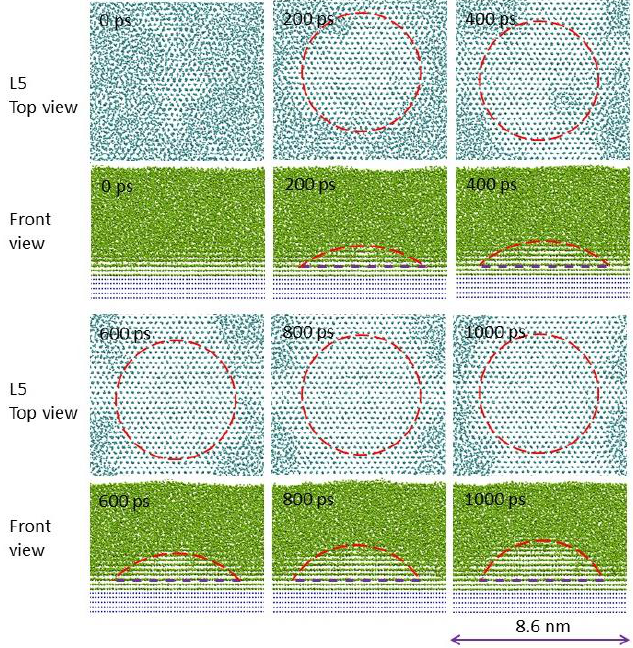
Figure 12. Time-averaged atomic positions of a simulation system with 2% lattice misfit demonstrating the unconstrained cap formation process after nucleation at a higher temperature. Nucleation occurred at Δ T n = 40 K on a substrate of 2r N = 8.6 nm to provide the 2D nucleus that covers the entire substrate surface (see Figure 5). The system was then allowed to solidify at Δ T = 90 K (corresponding to 2r n = 6.3 nm, as marked by the purple dashed lines in the front views). With increasing time, the 2D nucleus grows into spherical caps with increasing cap height. The top views of L5 are used to demonstrate that the cap grows in height without lateral spreading, as shown by the stable size of the crystalline regions indicated by the red circles.